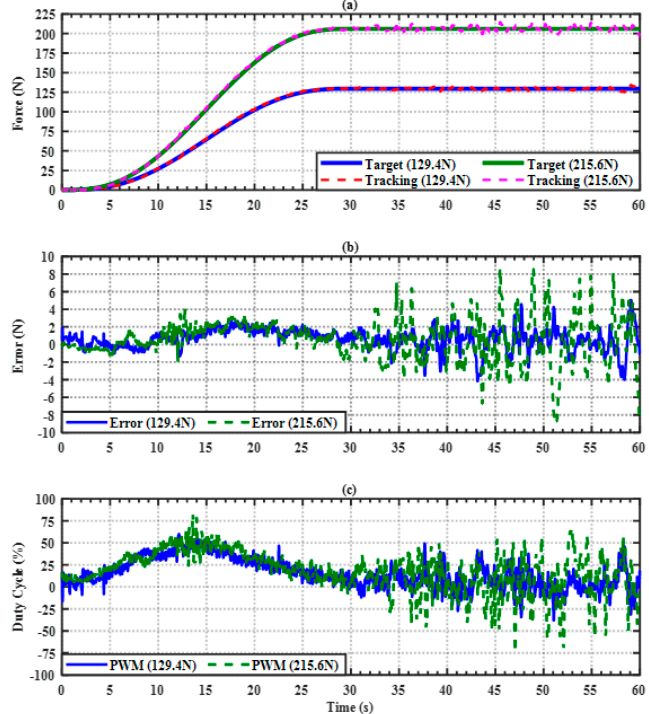
Figure 8. Dynamic bodyweight unloading force control of ILESO − PSMC, 15% (129.4 N) and 25% (215.6 N) of male subject body weight (862.4 N). ( a ) Unloading force tracking response; ( b ) unloading force tracking error; ( c ) duty cycle of PWM.